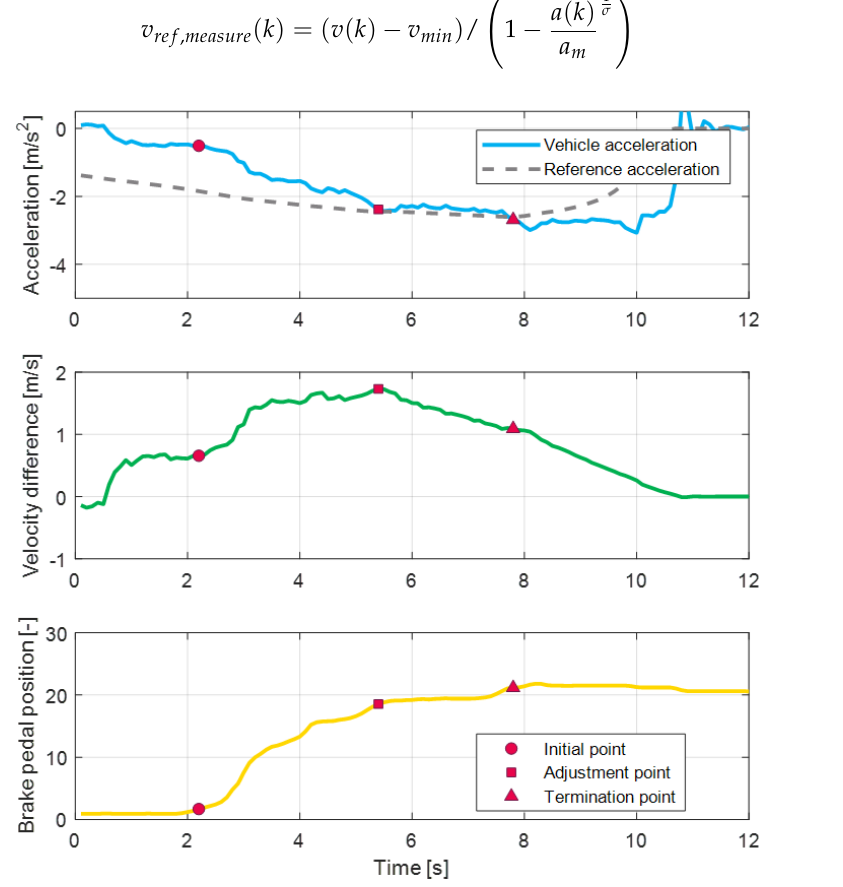
Figure 15. Detailed process for calculation of parametric model equations to predict deceleration